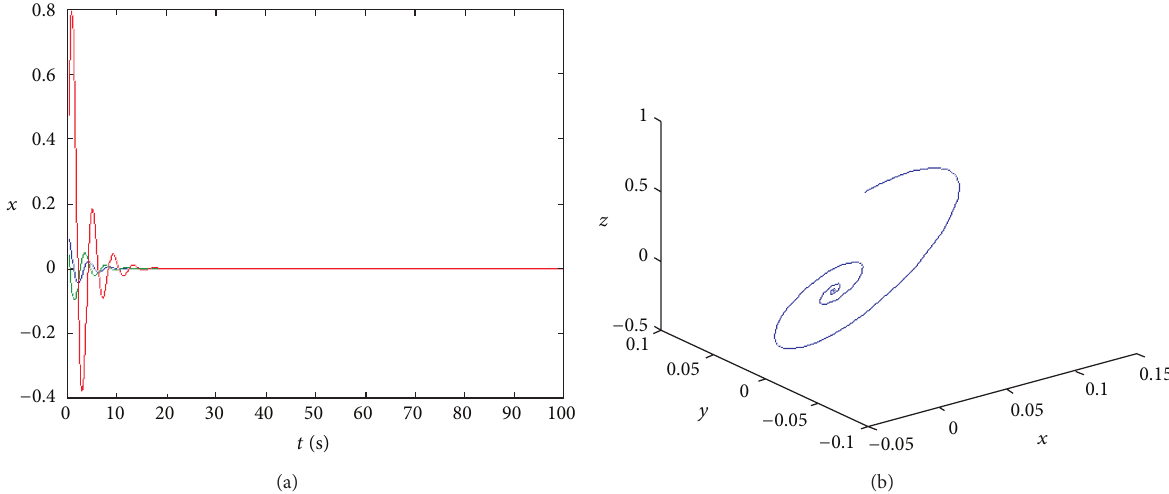
Figure 3: Time history and phase diagram of system (3) with 𝑎 = −1 , 𝑏 = 1 , 𝑐 = −1 , 𝑒 = 18 , and 𝑑 = −0.2